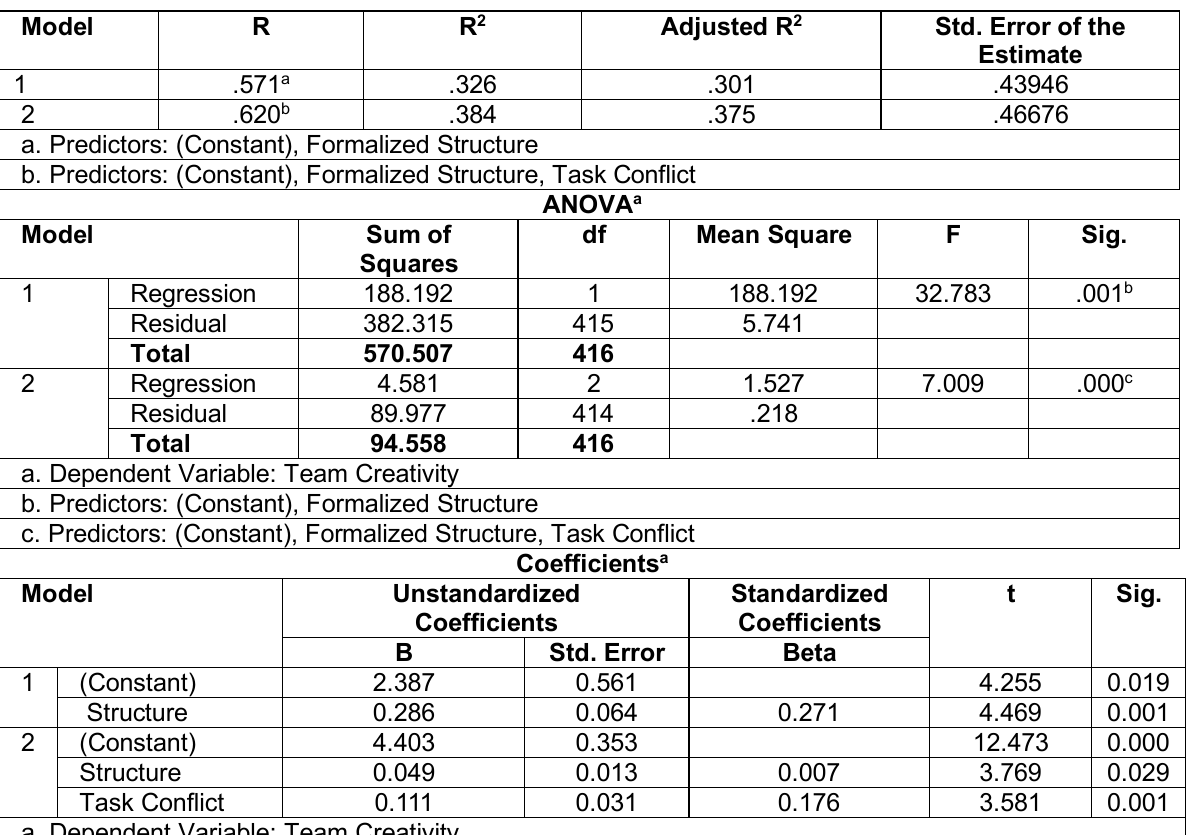
Table 9 : Regression of team creativity and Structure Mediated by Task